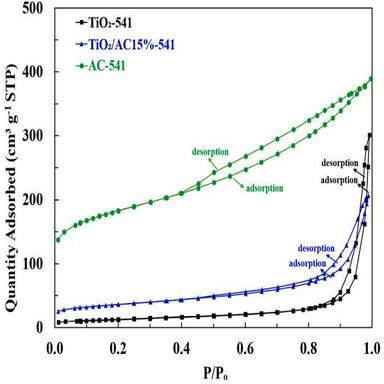
Nitrogen adsorption and desorption isotherm patterns of TiO2-541, TiO2-AC15%-541, and AC-541.